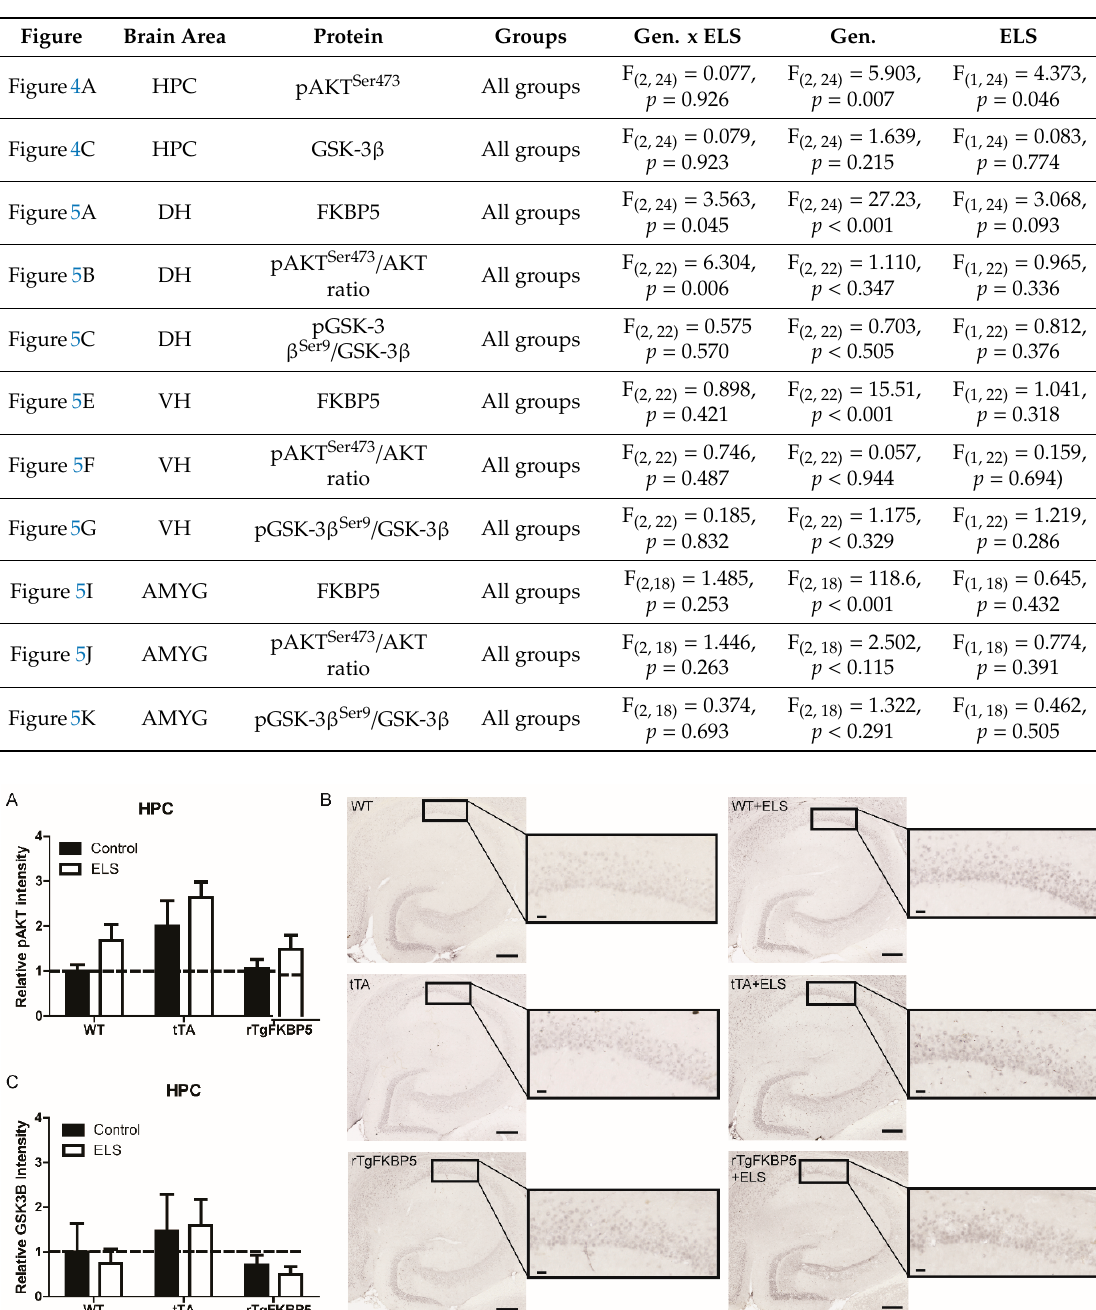
Table2. Summaryofstatisticalanalysesbytwo-wayANOVAofstainingandWesternblots. DH = dorsal; VH = ventral; AMYG = amygdala.